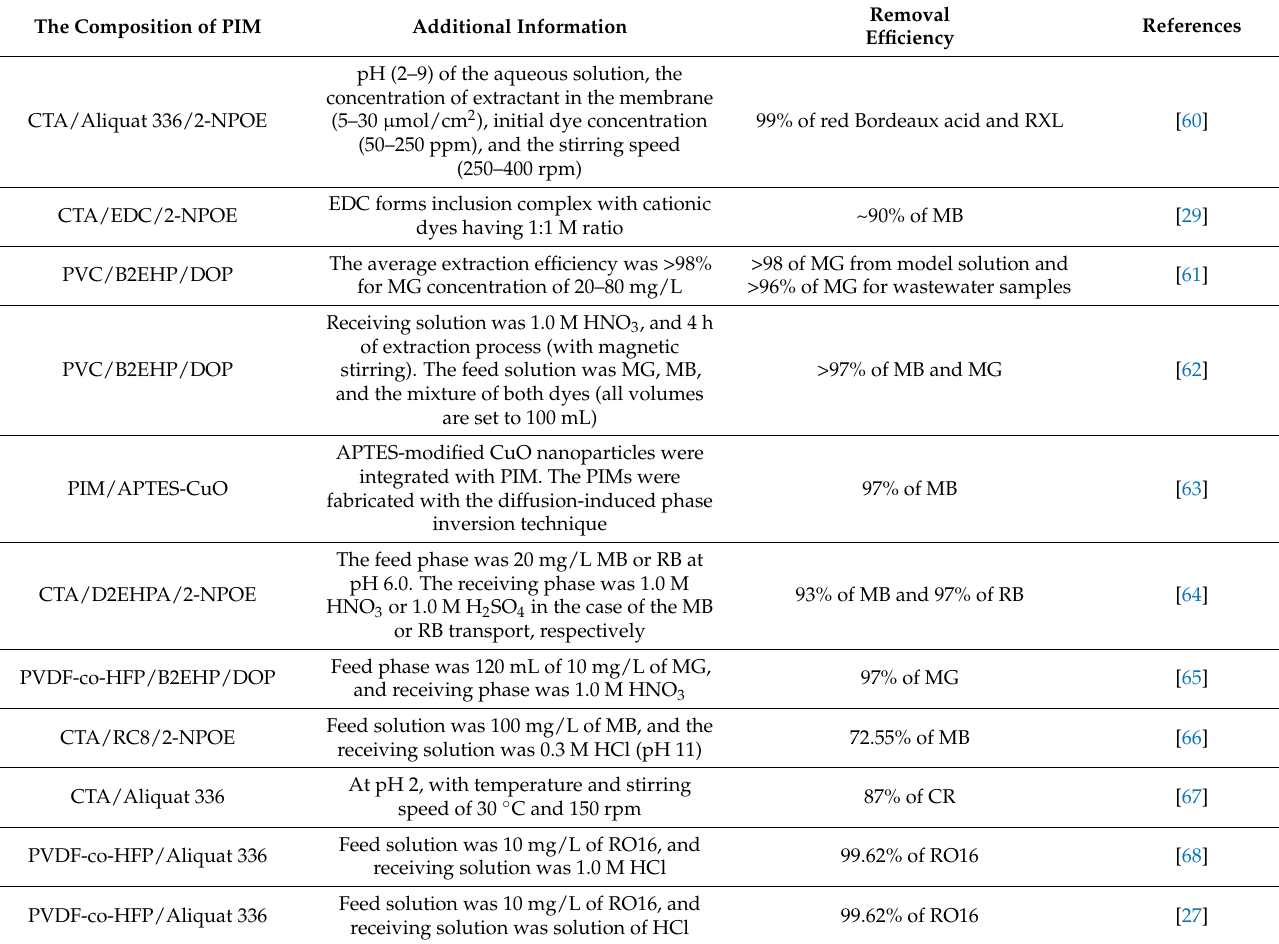
Table 3. Examples of removal of synthetic dyes by various